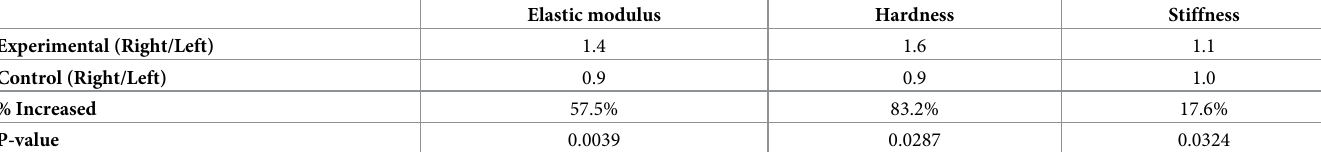
Oliver-Pharr equations. The raw averages are shown in Table 3 and Fig 6. As described in sta- tistical analysis, these values for combining all values from a specific treatment. The control group left and right limbs did not have statistically different values from each other, while the experimental group did for Elastic Modulus and Stiffness. There were statistical differences between the experimental left limb (saline injection) and the right and left limbs of the control groups for Elastic Modulus and Stiffness as seen in Fig 6.